Question: Looking at the figure, what chart type is it?
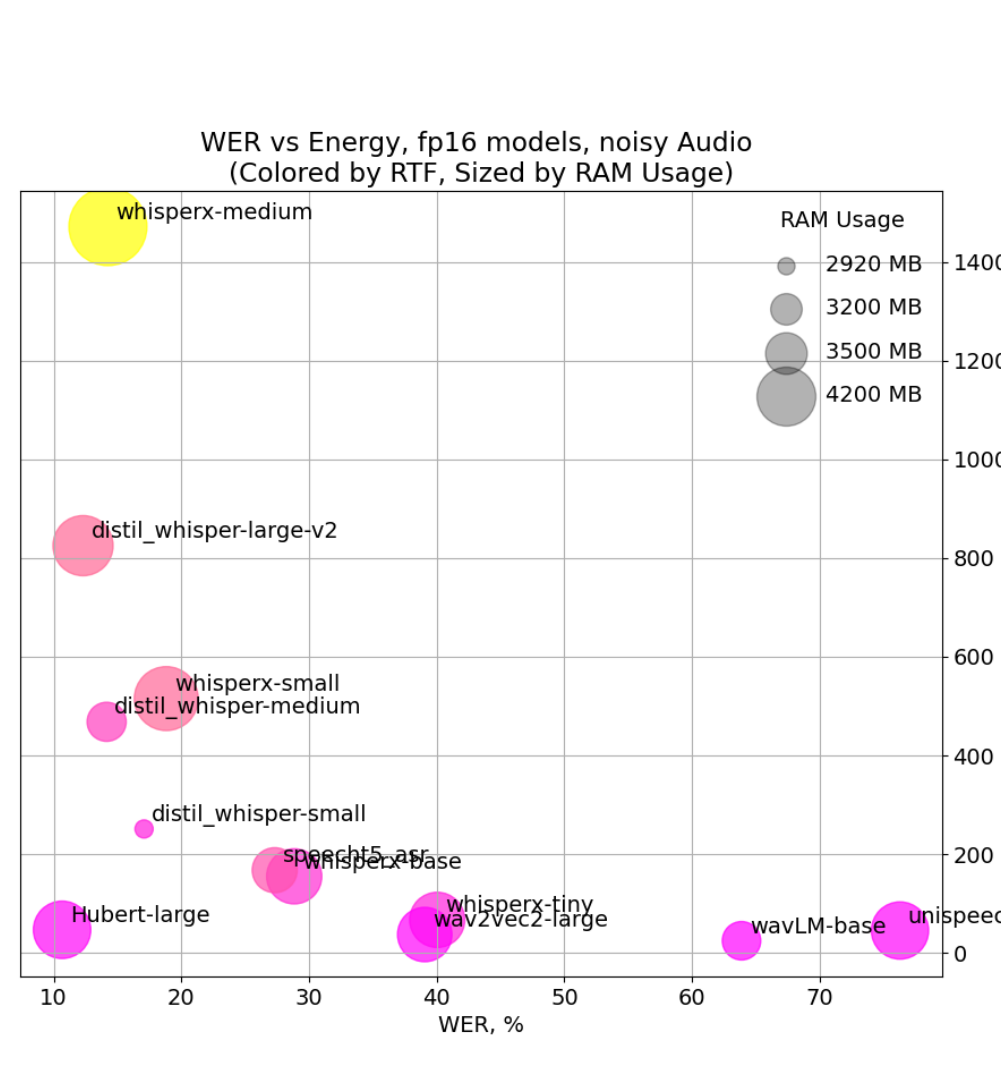
Answer: scatter